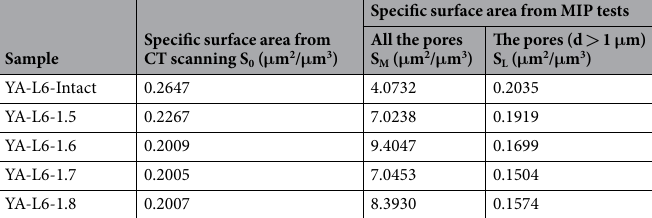
—the area of the total pore boundary 0 —the total surface area of all the pores divided M —the total surface area of pores (d > 1 L